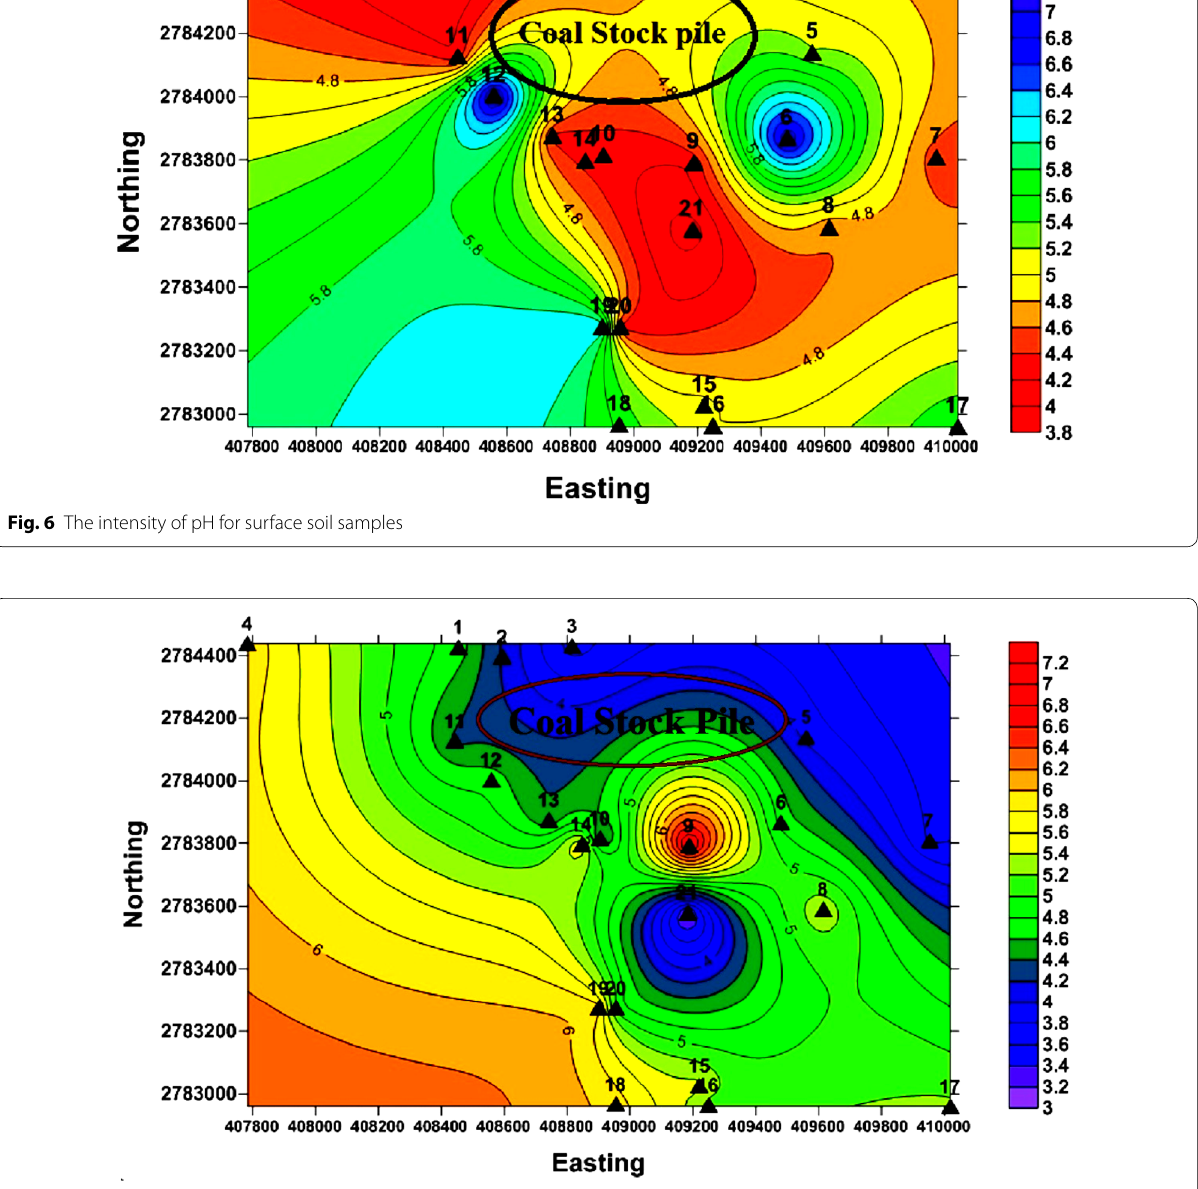
Fig. 7 The intensity of pH for sub-surface soil